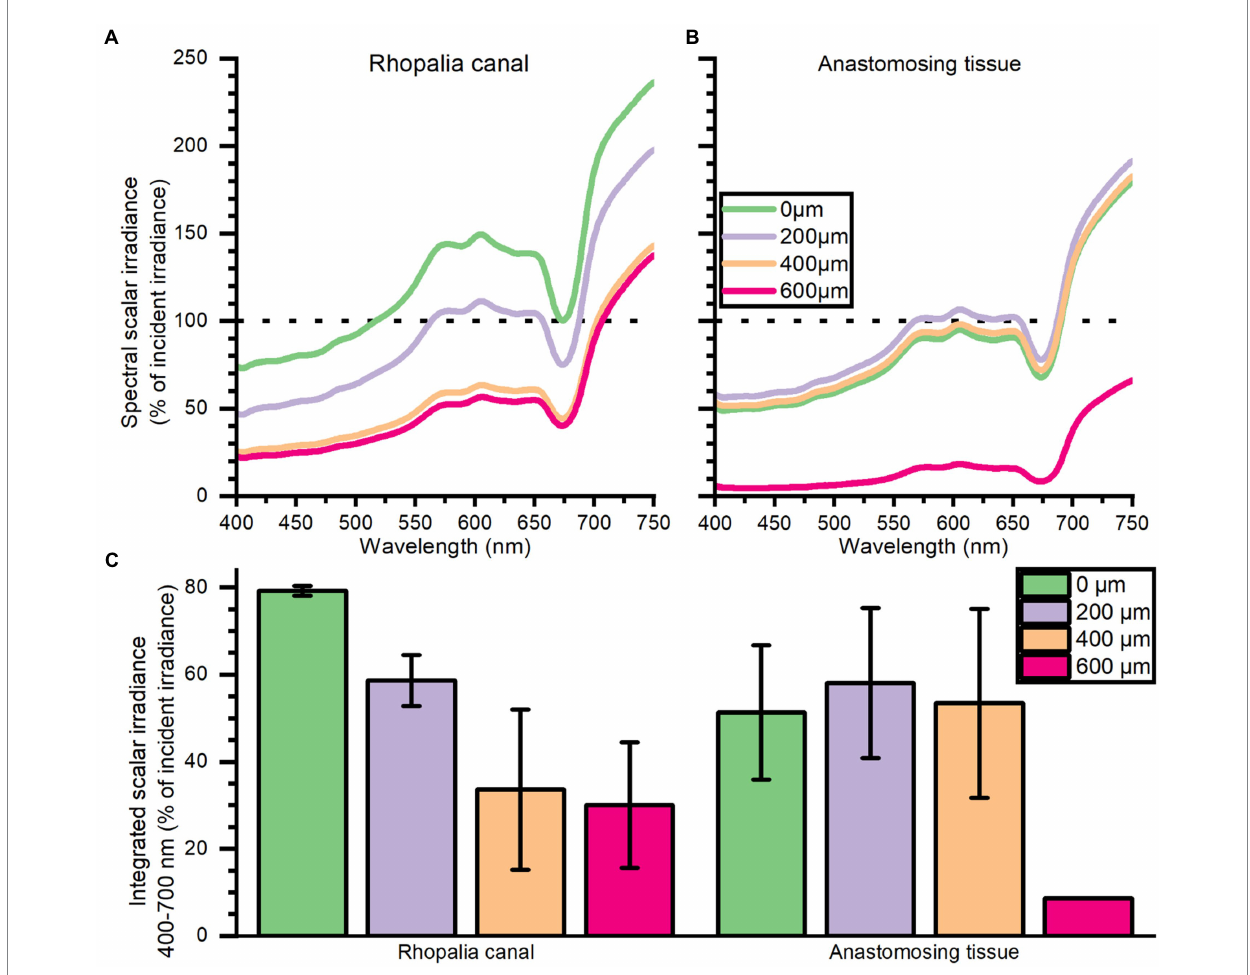
FIGURE 3 Spectral scalar irradiance (in % of incident irradiance) measured near the subumbrella rhopalia canal (A) and anastomosing tissue (B) , and integrated scalar irradiance (400–700 nm) (C) . Data represent mean ± SEM of 2 rhopalia canals and 3 anastomosing tissue areas (except for the 600 μ m). For increased clarity standard errors are not shown in panel (A,B) , but are reflected in the ± SEM shown for integrated values in panel (C)